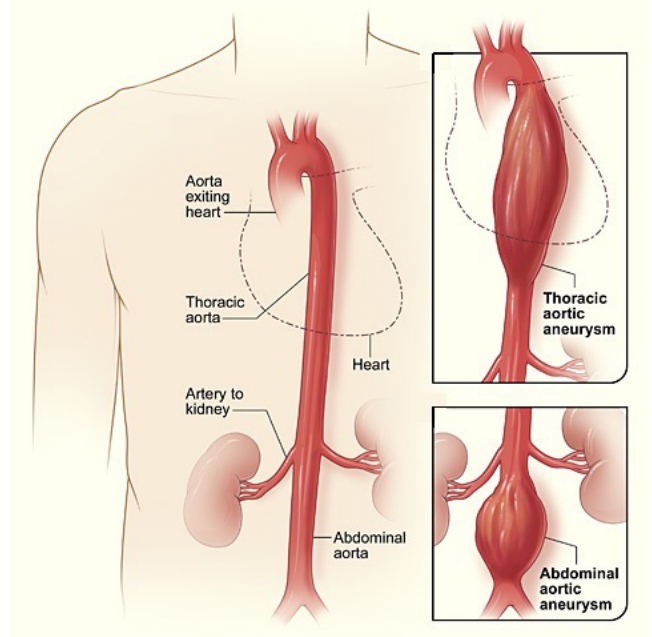
Figure 1. Anatomy of the